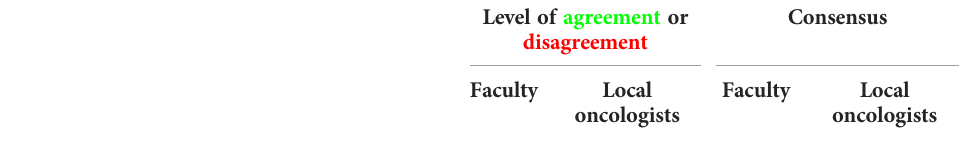
TABLE 1 Level of agreement and disagreement and consensus status on statements regarding